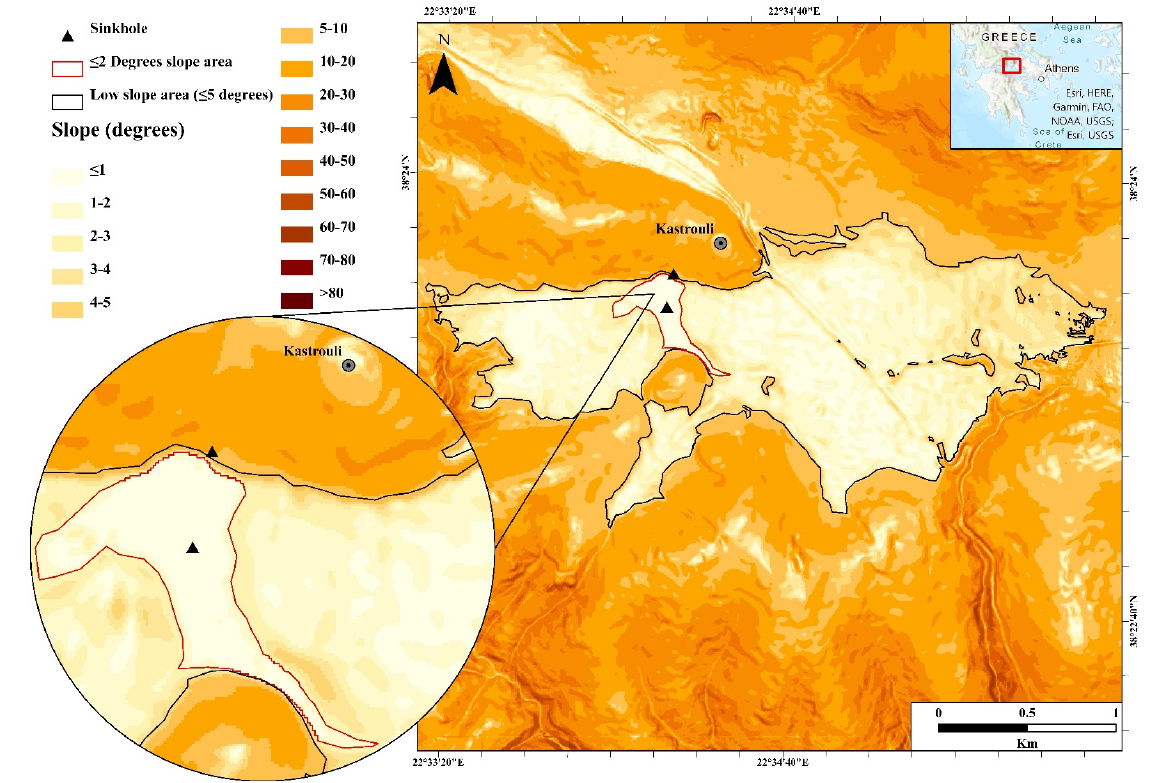
Figure 11. Morphological slopes of Kastrouli area. The black outline identifies the area with inclina- tions fluctuating between 0 and 5 degrees (0 and 8.75%). On the contrary, the red outline indicates an area of 0.10 Km 2 , with inclinations fluctuating between 0 and 2 degrees (0 and 3.49%). Gray triangles are the sinkholes.